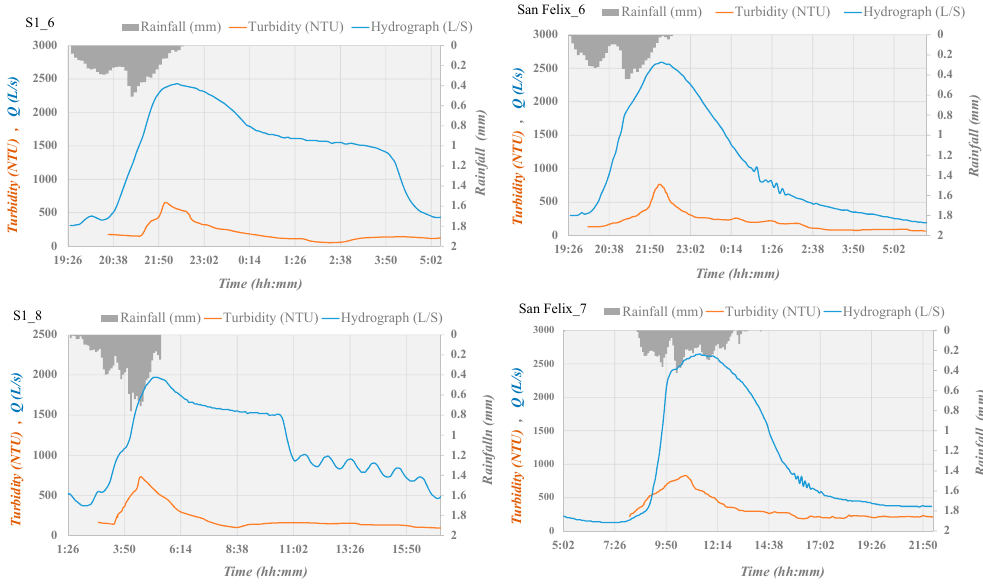
Figure 5. Rainfall, hydrographs and turbidity-pollutograph of events: S1_1; S1_3; S1_5; S1_6; S1_8;